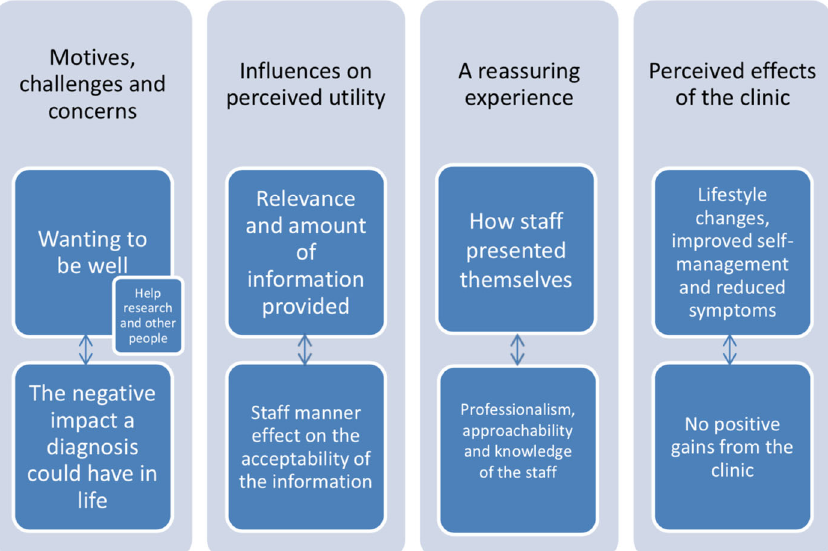
Fig. 2 Overview of the themes and sub-themes presented in the data. Indicated are the themes and sub-themes of patients ’ views on their experience of the clinic and its utility, which were